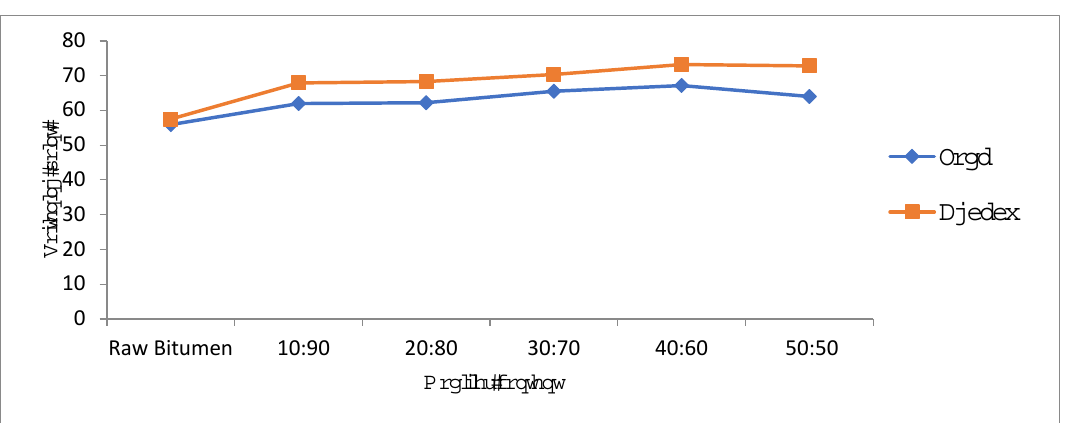
Fig. 7: Viscosity in raw bitumen and modifier content